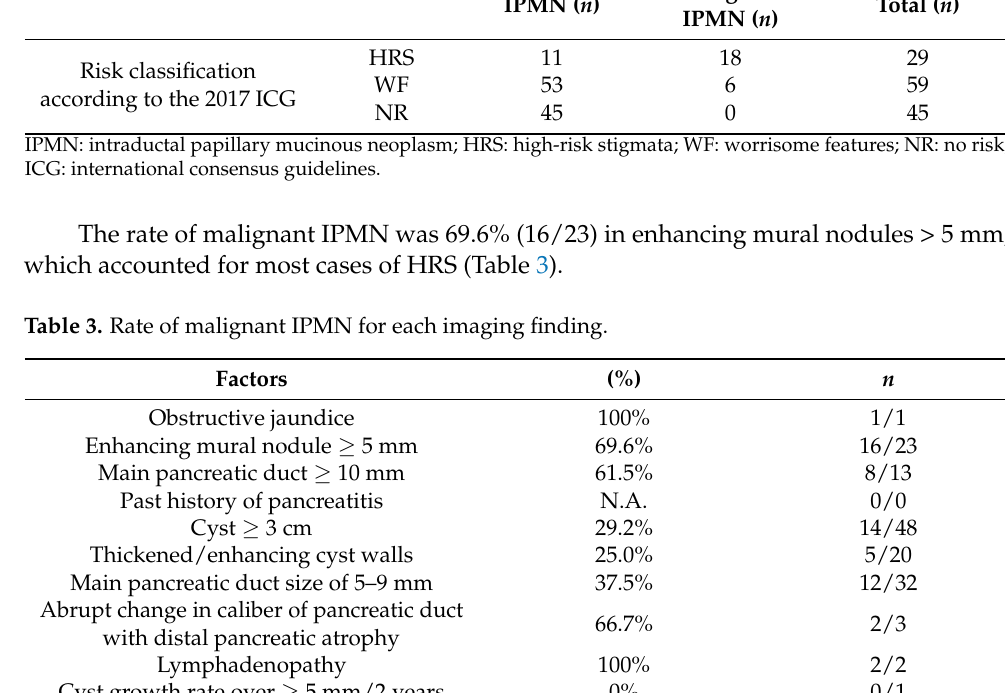
Table 2. Final diagnostic results for each risk classification according to the 2017 ICG. Risk classification according to the 2017 ICG